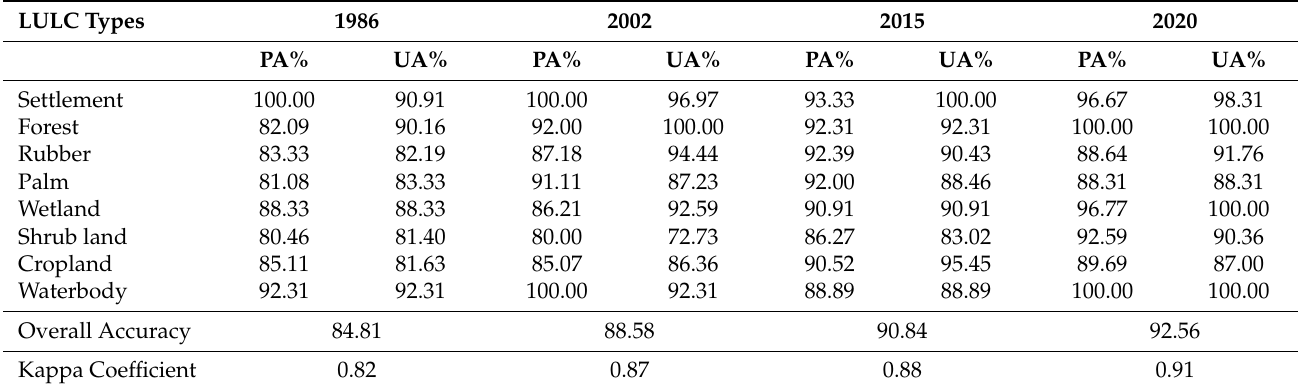
Table 3. Accuracy assessment results of the LULC